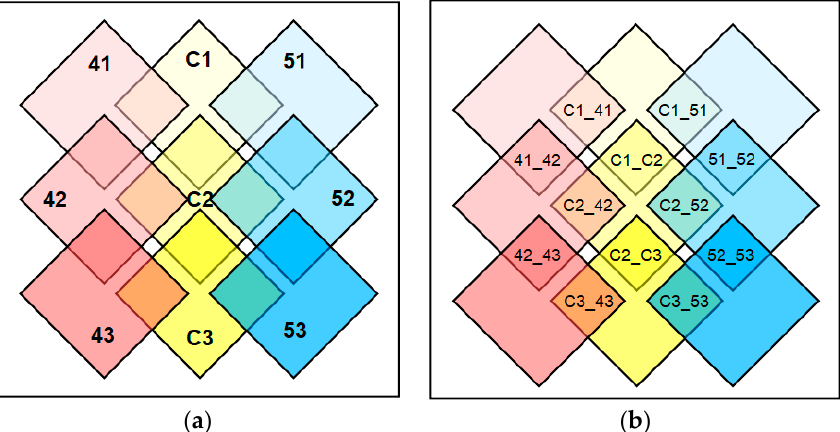
Figure 1. A diagram explaining how the RNA-Seq results were paired and compared to select differentially expressed genes (DEGs). ( a ) Large rectangles indicated by C1, C2, and C3 represent samples in 8 days after flowering (DAF), 25 DAF, and 45 DAF of Youngsan control plants, respectively. In the same manner, 41, 42, and 43 represent samples from 8 DAF, 25 DAF and 45 DAF of CpFatB4 , while 51, 52, and 53 for CpFatB5 transgenic plants in different stages in the order. ( b ) DEGs were identified in six pairs based on developmental stage and in another six pairs based on an overexpressed transgene, among nine samples in Figure 1a. The small rectangle made by the overlap of two neighboring large rectangles in Figure 1a shows DEGs between two samples, indicated by two large rectangles. For example, a small rectangle designated with 41_42 indicates DEGs detected by the log2-fold change between samples 41 and 42, and C1_41 indicates DEGs between samples C1 and 41.